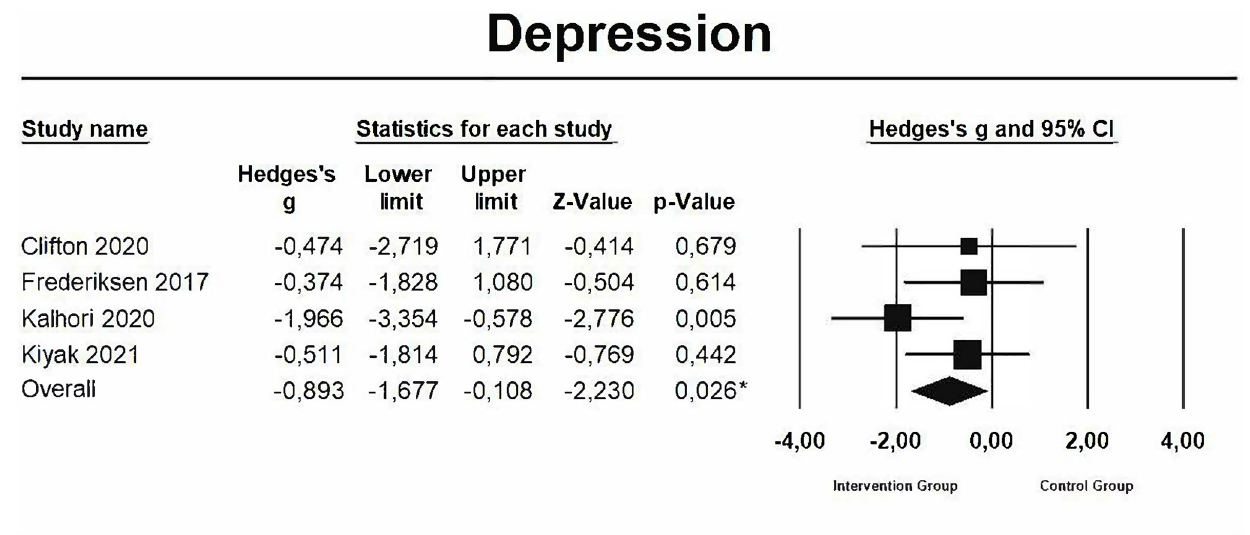
Fig 3. Results for depression. Hedges´ g, confidence interval (CI), Z-Value, p-Value and forest plot for depression (created with CMA Software (Borenstein et al. 2015) [39]). � p value < .05. https://doi.org/10.1371/journal.pone.0282065.g003 for the combined studies was 1,33732 (0,98280; 1,81968). Using Trim and Fill these values were unchanged. The method suggests that no studies were missing. This is visually under- lined: the white and black diamond lie on top of each other in the funnel plot and do not devi- ate (Fig 5).